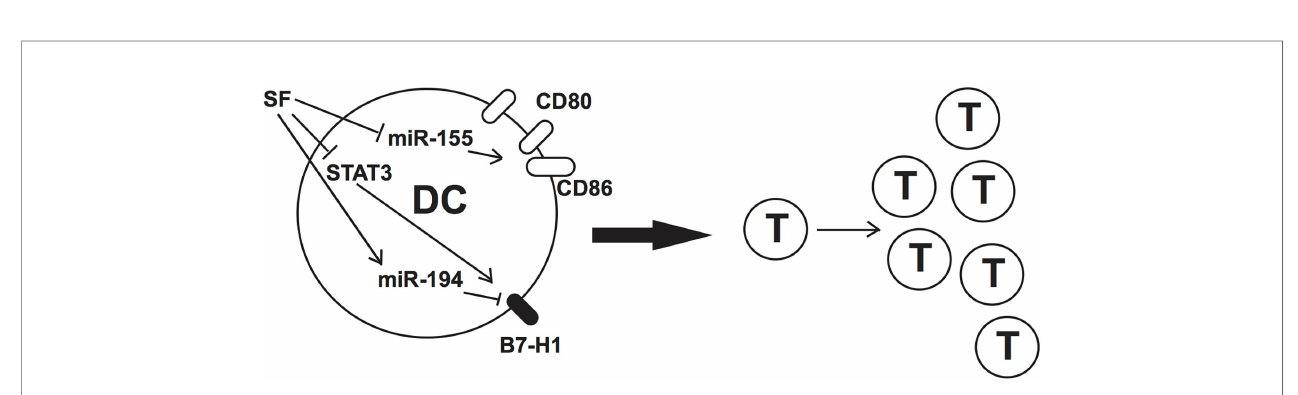
FIGURE 7 | Schematic representation of our results and